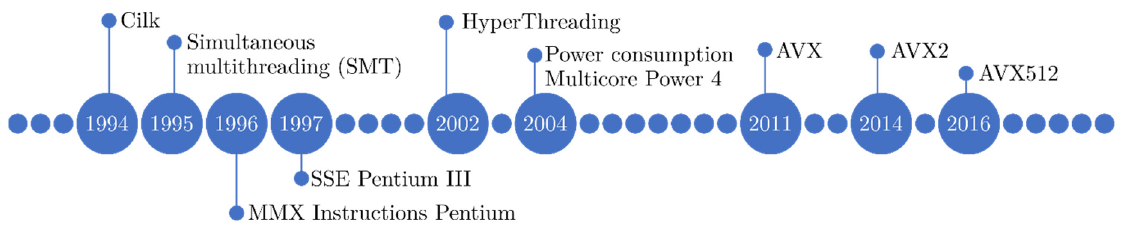
Figure 1. Most significant milestones over time on CPU-based hardware acceleration for image processing.